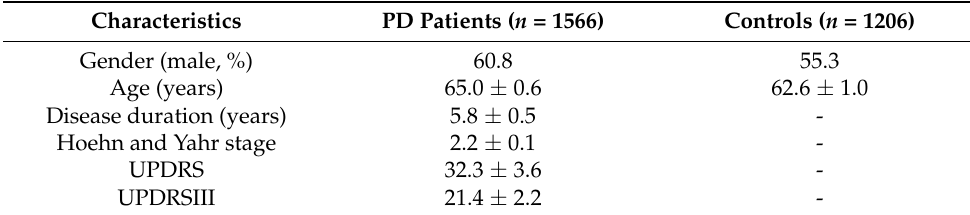
Figure 1. PRISMA flow diagram. HRV: heart rate variability. Table 1. Study population,